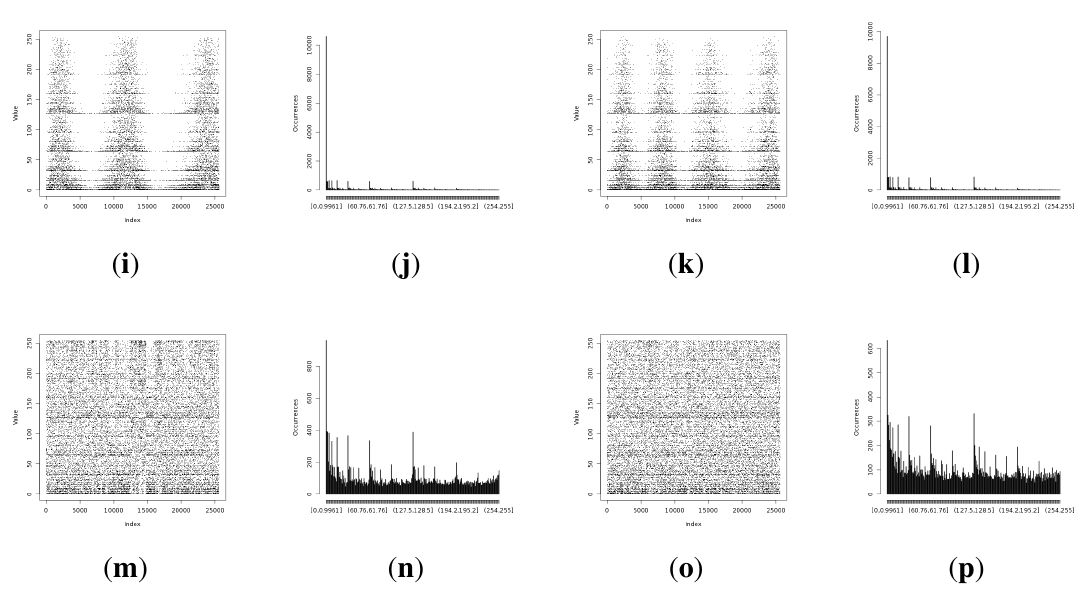
Figure 11. Experiment results representing random values harvested during the isolation experiment. ( a ) Entropy from Light (1) sensor with the original method; ( b ) distribution for the Light (1) sensor with the original method; ( c ) entropy from the Light (1) sensor with the statistically fine-tuned method; ( d ) distribution from the Light (1) sensor with the statistically fine-tuned method; ( e ) entropy from the Light (2) sensor with the original method; ( f ) distribution from the Light (2) sensor with the original method; ( g ) entropy from the Light (2) sensor with the statistically fine-tuned method; ( h ) distribution from the Light (2) sensor with the statistically fine-tuned method; ( i ) entropy from the humidity sensor with the original method; ( j ) distribution from the humidity sensor with the original method; ( k ) entropy from the humidity sensor with the statistically fine-tuned method; ( l ) distribution from the humidity sensor with the statistically fine-tuned method; ( m ) entropy from the temperature sensor with the original method; ( n ) distribution of the harvested entropy collected from the temperature sensor with the original method; ( o ) entropy from the temperature sensor with the statistically fine-tuned method; ( p ) distribution from the temperature sensor with the statistically fine-tuned